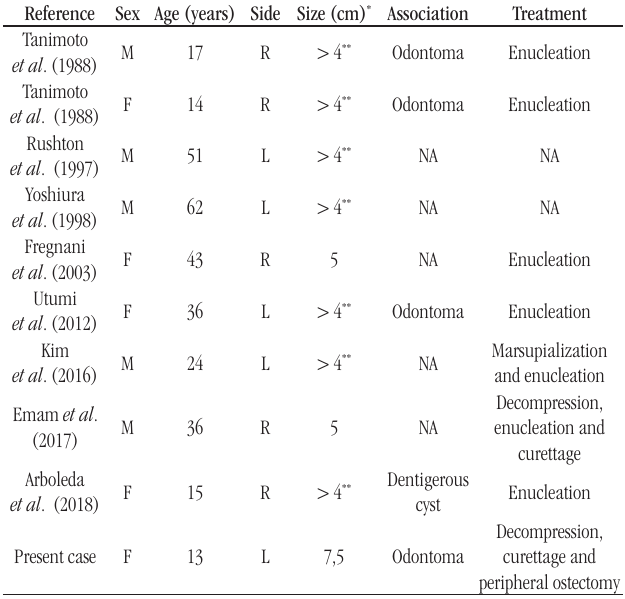
TABLE – Summary of extensive (larger than 4 cm) calcifying odontogenic cysts in the posterior maxillary region (premolar to molar) reported in the